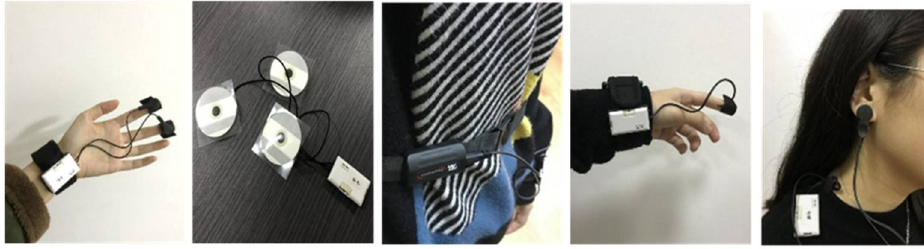
Figure 2. Biometric wearable sensing devices for measuring EDA, EMG, RESP, SKT,